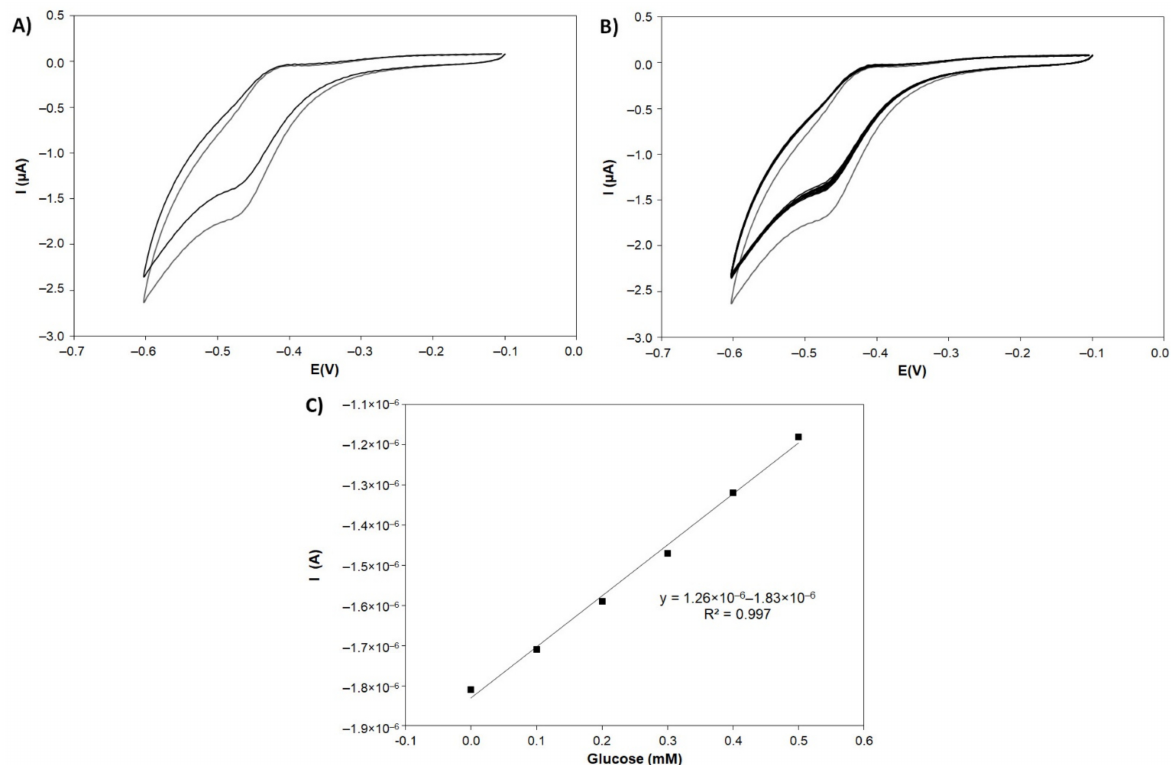
Figure 8. ( A ) Cyclic voltammograms of the GOX/PANI-AuNPs/SNGC biosensor in absence (grey) and in presence (black) of 0.5 mM of glucose in 0.1 M PBS (pH 6.8), scan rate 100 mV/s. ( B ) Cyclic voltammograms of the GOX/PANI- AuNPs/SNGC biosensor in absence (grey) and in presence (black) of 0.5 mM of glucose for ten replicates (repeatability study with an RSD value of 2.41%), in 0.1 M PBS (pH 6.8), scan rate 100 mV/s. ( C ) Calibration plot of glucose by using the